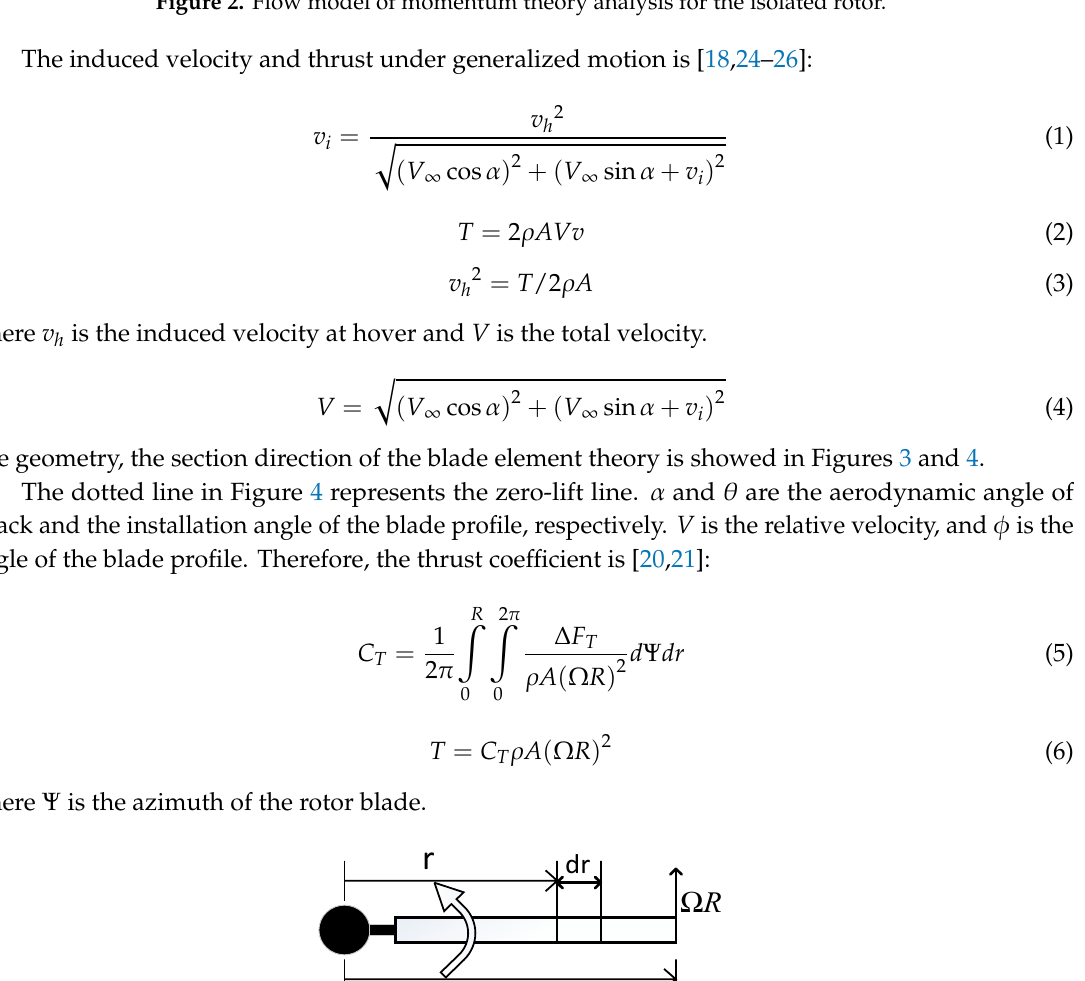
Figure 2. Flow model of momentum theory analysis for the isolated rotor.